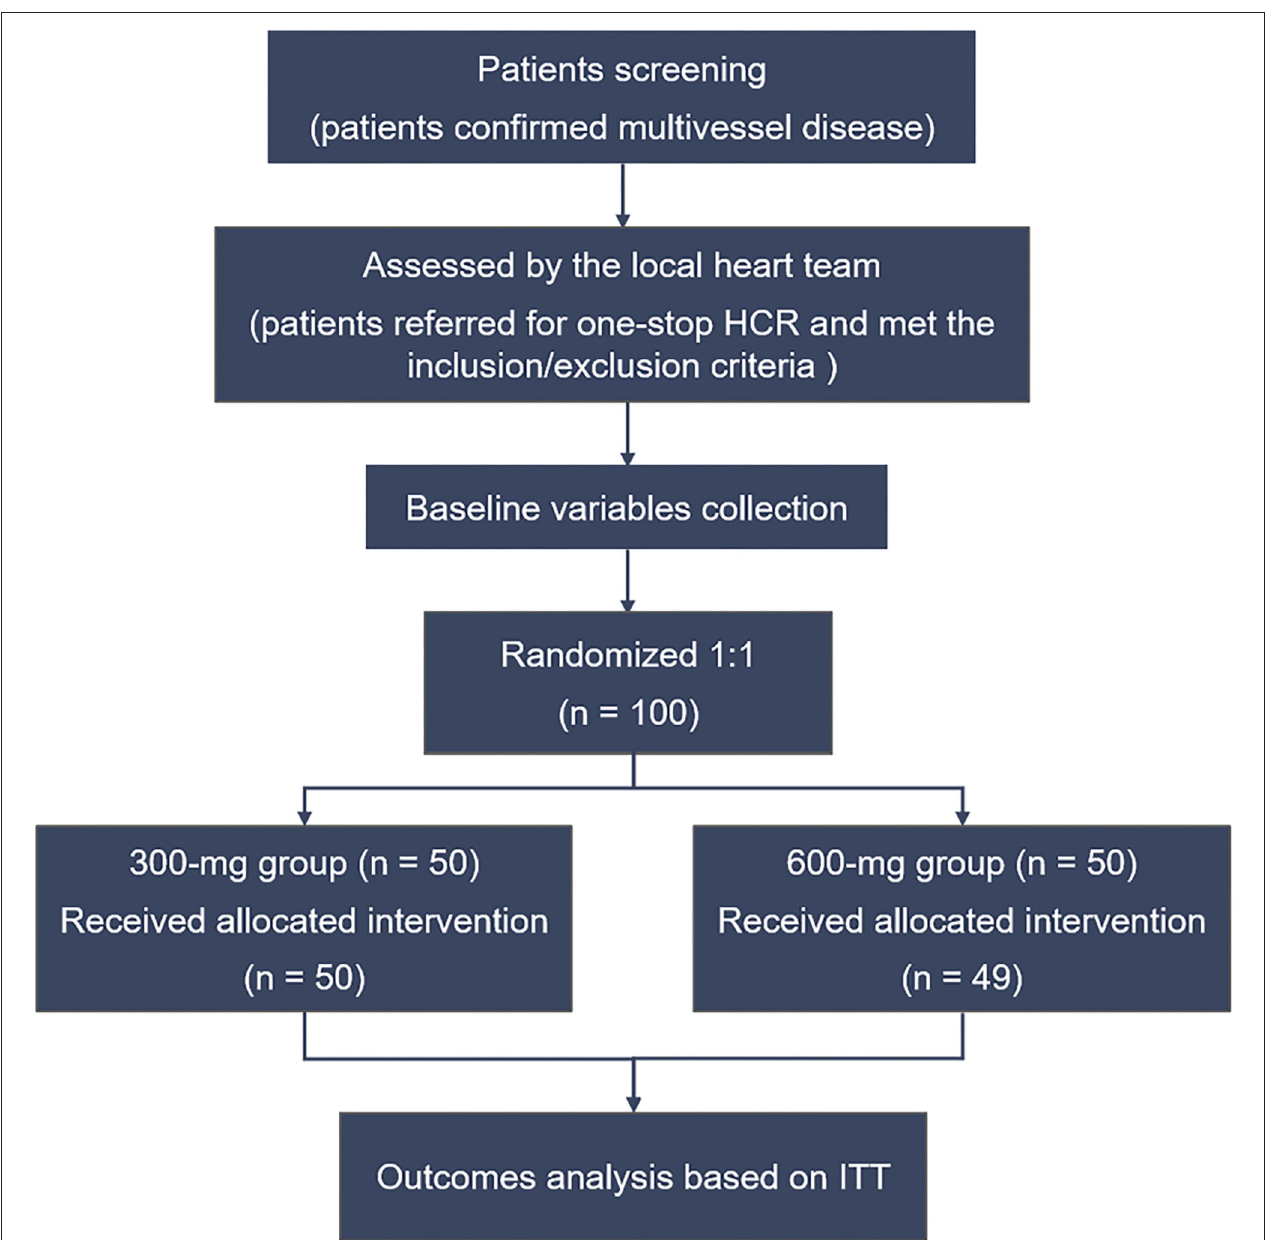
FIGURE 1 | Flow chart of the study. HCR, hybrid coronary revascularization; ITT,